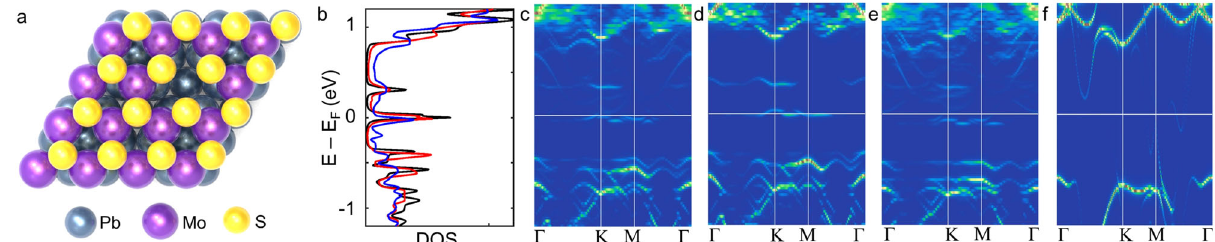
Fig. 5 The effect of the substrate interaction strength on the density of states of the molybdenum vacancy. a The simulation cell used in calculations. b PDOS projected to the MoS 2 overlayer at three different interaction strengths, no interaction (black), half interaction (red) and full interaction (blue). c The band structure of MoS 2 in the case of half interaction with the substrate with a defect with bands unfolded to the BZ of a primitive cell of MoS 2 . d , e The same as Fig. 4c but with no interaction and full interaction with the substrate, respectively. f The same as in Fig. 4c, i.e., with half interaction but without any